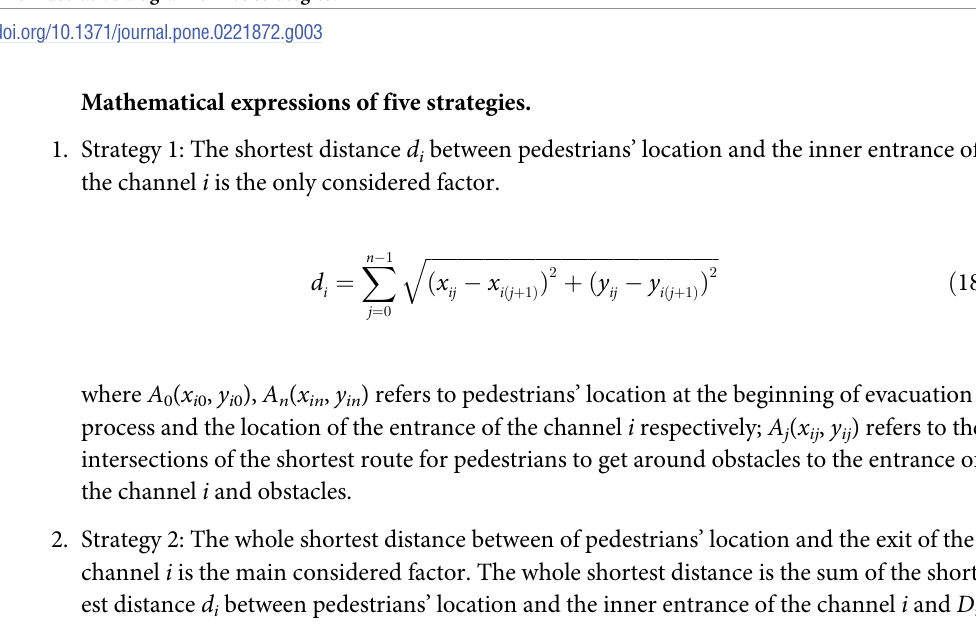
Fig 3. The illustrative diagram of five